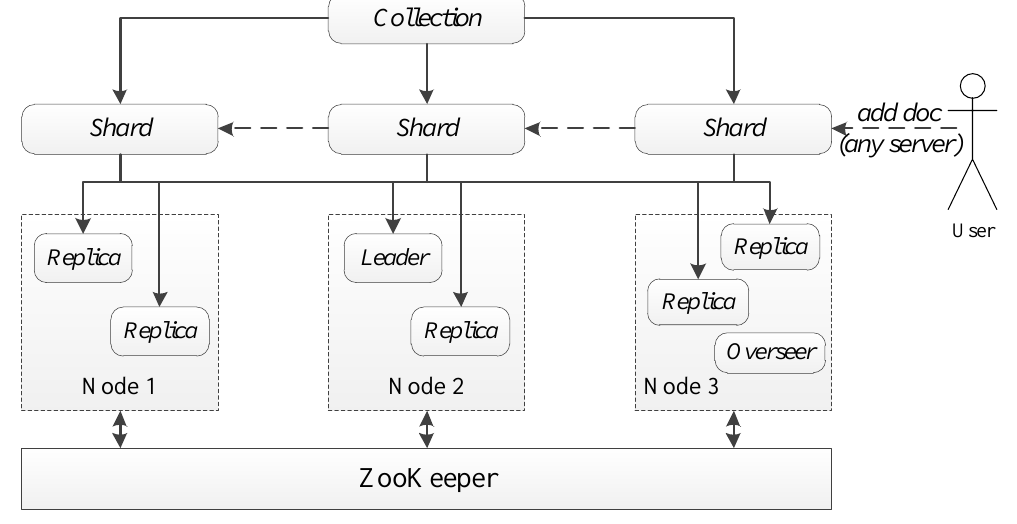
Figure 6. SolrCloud.